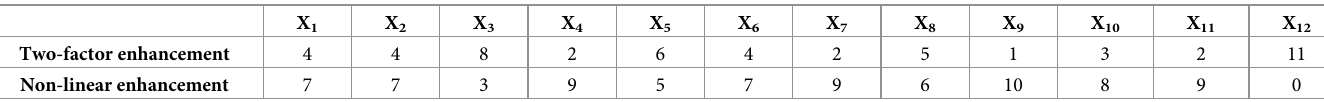
Table 7. Statistics of the types of interactions between the factors and other